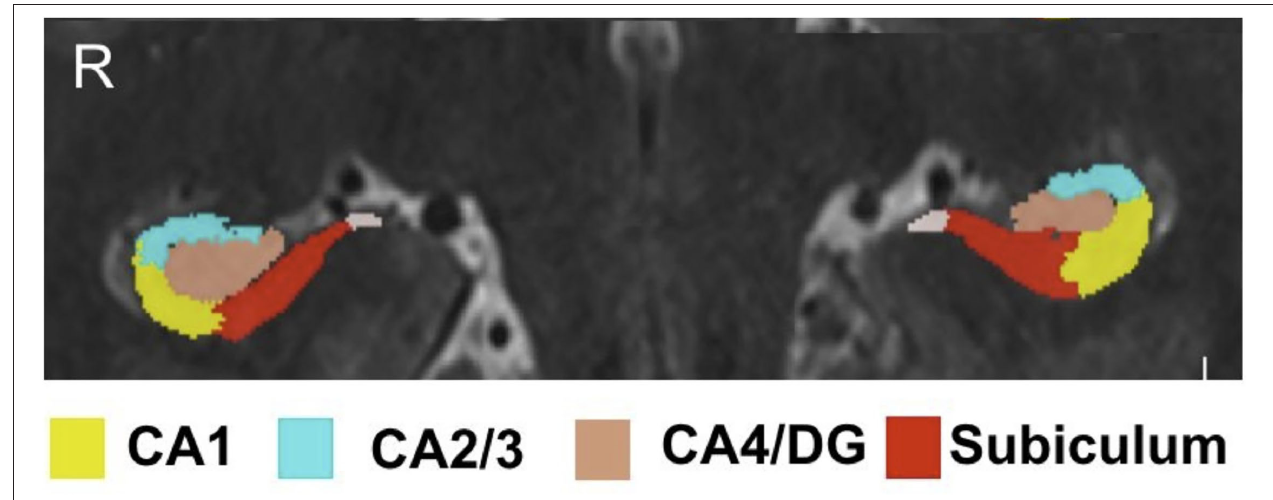
FIGURE 1 | Hippocampal subfield segmentation by ASHS. Subfield segmentation generated by ASHS. The subfields shown include: CA1, CA2/3, CA4/DG, and